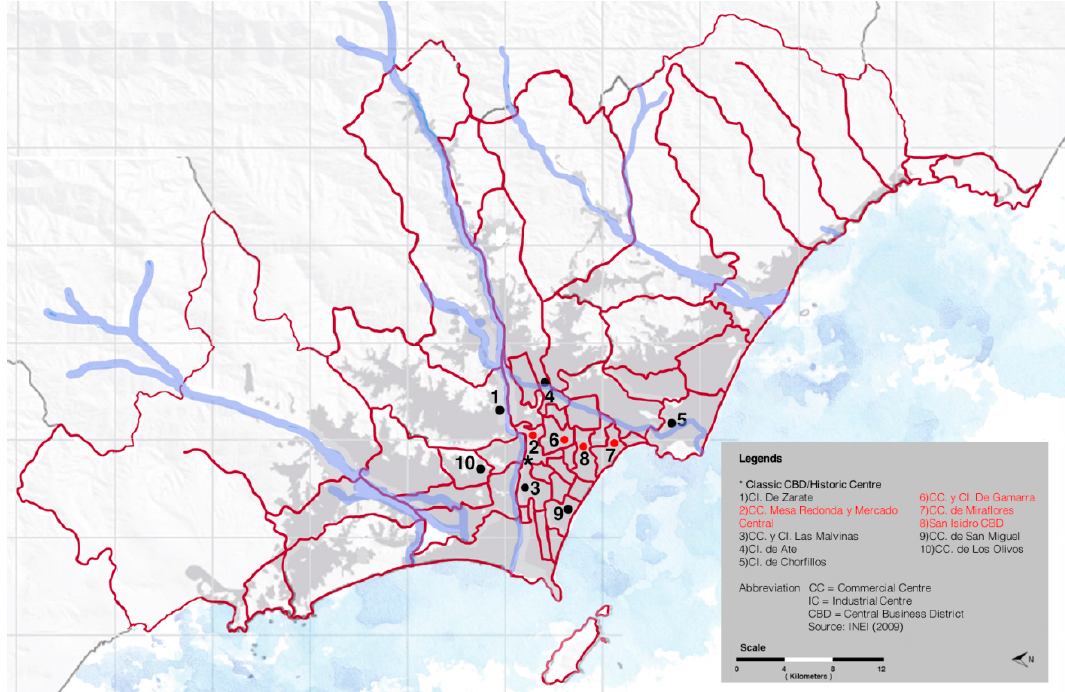
Figure 3. Employment centres in Lima in 2008. Source: Reference [18]. Map translated and edited by authors.